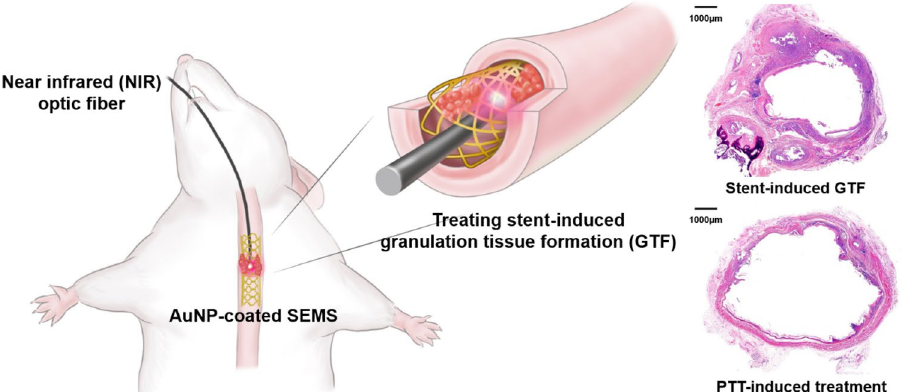
Figure 1. Schematic illustration of the photothermal therapy (PTT) method using a gold nanoparticle (AuNP)- coated self-expandable metallic stent (SEMS) and representative hematoxylin and eosin images shows PTT therapeutic effects (magnification, ×